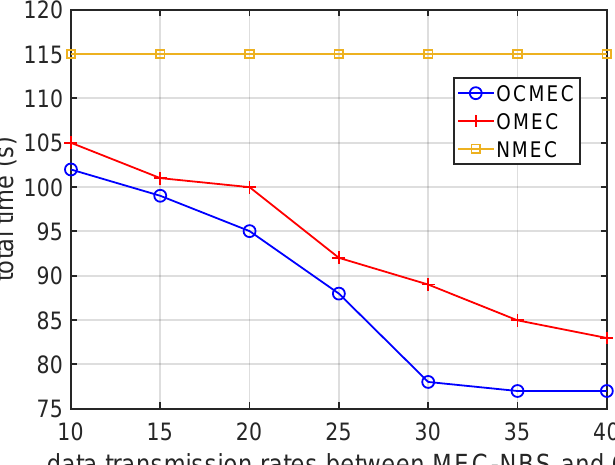
Figure 9. f gained by the 3 schemes with the increase of s NBS2C MEC-NBS and C, k = 1,2, . . . , K .